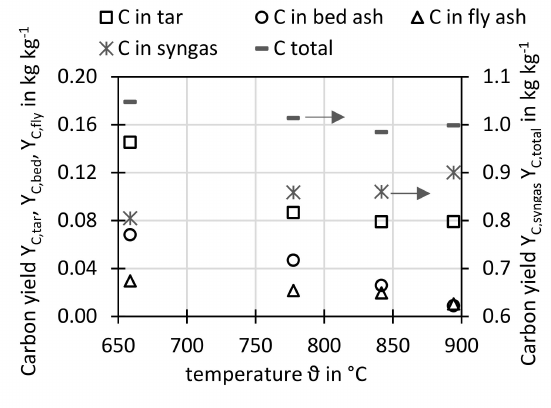
Figure 17. Carbon balance: Yield of carbon in syngas, tar, bed ash, fly ash and total sum for different gasifier